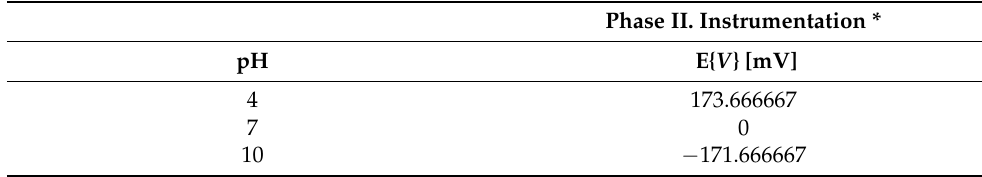
Table 2. Statistical sensitivity parameters derived from pH sensor characterization: Phase